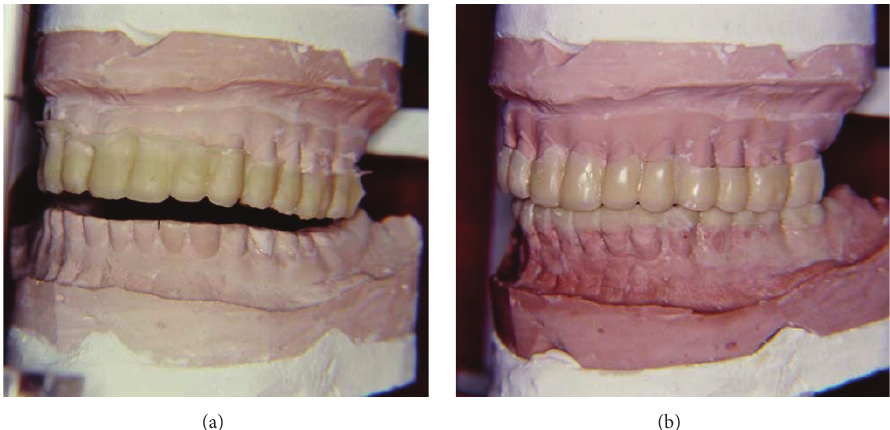
Figure 4: (a) Maxillary occlusal acrylic splint positioned in the second master cast set. (b) Waxing in the mandibular cast for manufacturing the second occlusal acrylic splint.